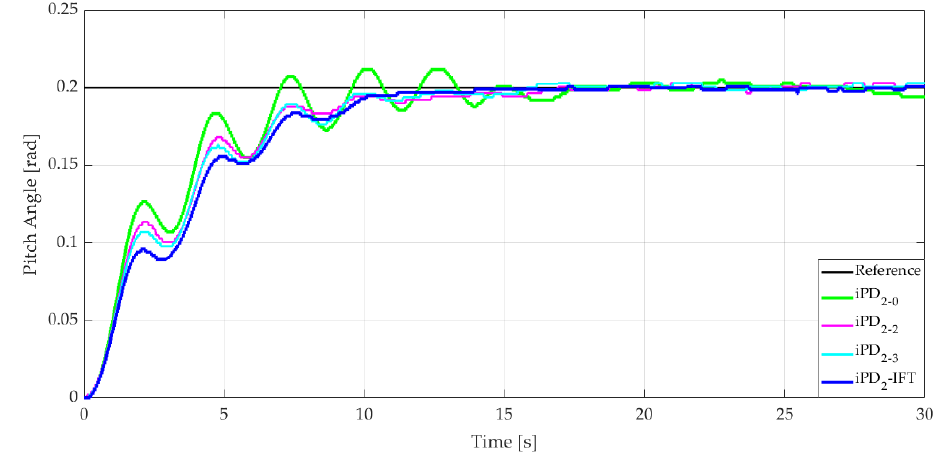
Figure 8. Control system responses with the iPD 2 controller during tuning with the IFT algorithm.